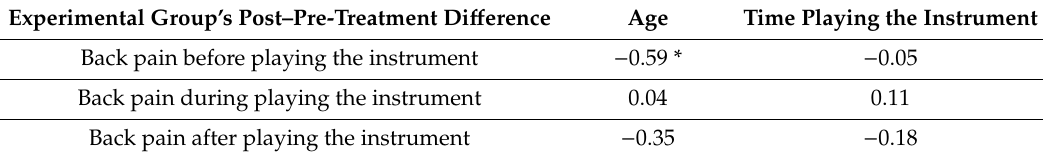
Table 5. Spearman’s rank correlation coe ffi cient. Correlation of the experimental group post–pre-treatment di ff erence in back pain (pre–during–after) with age and time playing the instrument. Experimental Group’s Post–Pre-Treatment Di ff erence Age Time Playing the Instrument Back pain before playing the instrument − 0.59 * − 0.05 Back pain during playing the instrument 0.04 0.11 Back pain after playing the instrument −